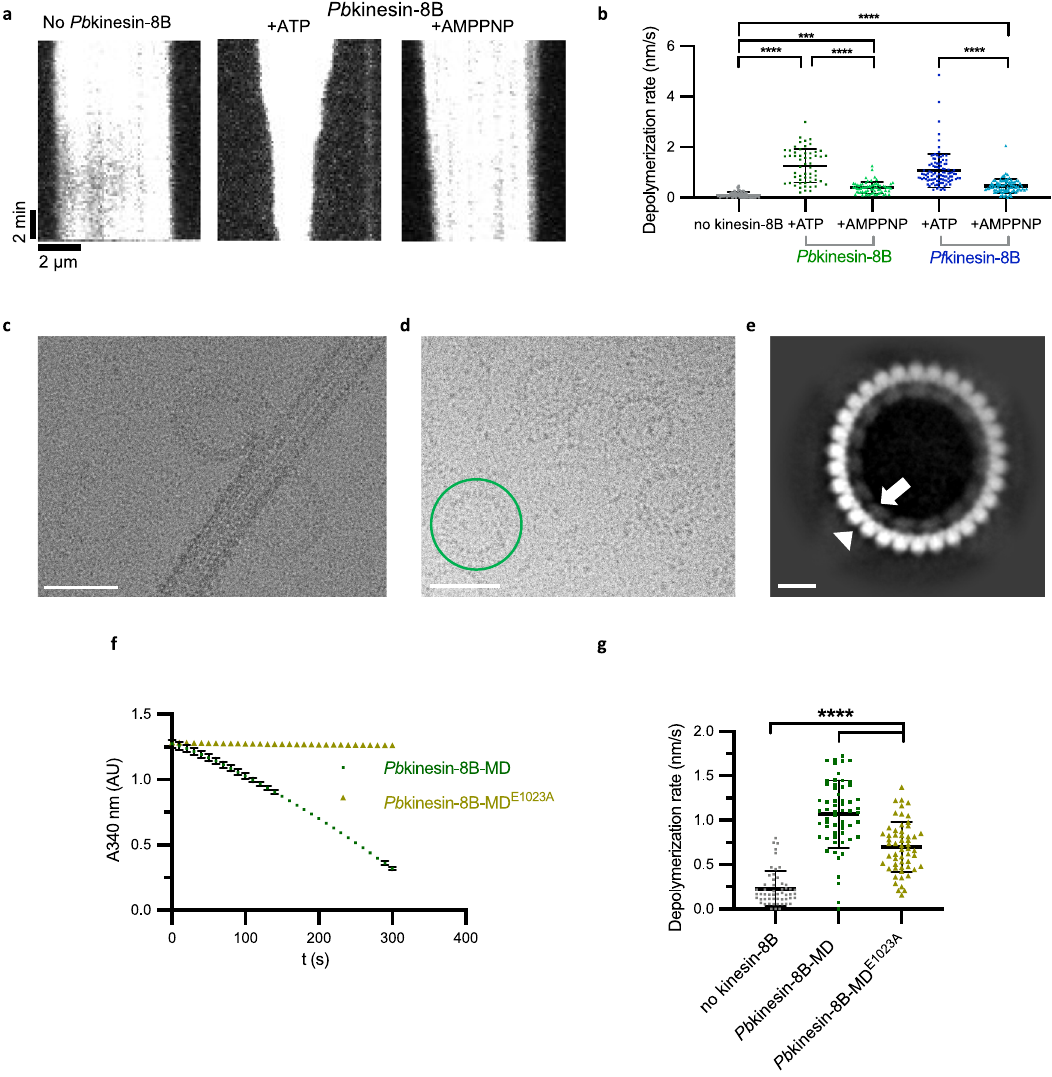
Fig. 2 | Plasmodium kinesin-8B motor domains are MT depolymerases. observed in three independent experiments. e Representative 2D class average a Representative TIRF-M kymographs of Pb kinesin-8B-MD depolymerising (7906 particles) of AMPPNP-dependent Pb kinesin-8B-MD-induced tubulin ring structure;theouterringisformedbycurved αβ -tubulindimers(whitearrowhead), paclitaxel-stabilised MTs in the presence of ATP (middle) and AMPPNP (right). while and inner ring is formed by individual Pb kinesin-8B-MD density (white Depolymerisation occurs at both MT ends in both conditions; b Paclitaxel- arrow). Scale bar=10nm. f Pb kinesin-8B-MD E1023A (olive green) does not exhibit stabilised-MT depolymerisation rate (nm/s) for Pb kinesin-8B-MD and Pf kinesin-8B- MT-stimulated ATPase activity in the enzyme-coupled assay used for measuring MD in the presence of ATP or AMPPNP compared to the no-kinesin control. Error ATPase activity ( n =3 for eachpoint, mean±SD),while WT Pb kinesin-8B-MD (dark bars represent the mean±SD and individual measurements are also plotted. green) induces a decrease in NADH absorbance (340nm), both in the presence of Ordinary one-way ANOVA was performed in Prism. Signi fi cance values are dis- 1 μ M GMPCPP MTs. g Paclitaxel-stabilised-MT depolymerisation rate (nm/s) for played as asterisks, **** p -values<0.0001; *** p -value=0.0002. n no-kinesin-8B =112 ends, n Pb kinesin-8B-MD,ATP =56 ends, n Pb kinesin-8B-MD,AMP =68 ends, n Pf kinesin-8B-MD,ATP = Pb kinesin-8B-MD and Pb kinesin-8B-MD E1023A in the presence of ATP compared to 103ends, n the no-kinesin control. Error bars represent the mean±SD and individual mea- =92ends. c Cryo-EM imageshowingproto fi lamentspeeling Pf kinesin-8B-MD,AMP surements are also plotted. Ordinary one-way ANOVA was performed in Prism. from MT wall and forming ring-like structures (observed in two independent Signi fi cance values are displayed as asterisks, **** p -values<0.0001; n no kinesin-8B = experiments). d Cryo-EM image showing ring structures formed by incubating 54 ends, tubulin and Pb kinesin-8B-MD in the presence of AMPPNP. A representative ring structure is highlighted with green circle. Scale bar in c , d =50nm. The rings were